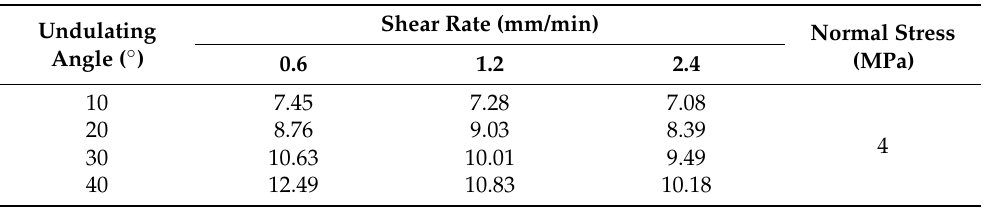
Table 3. Shear strength of structural planes with different undulating angles under different shear rates at 4 MPa normal stress (MPa).